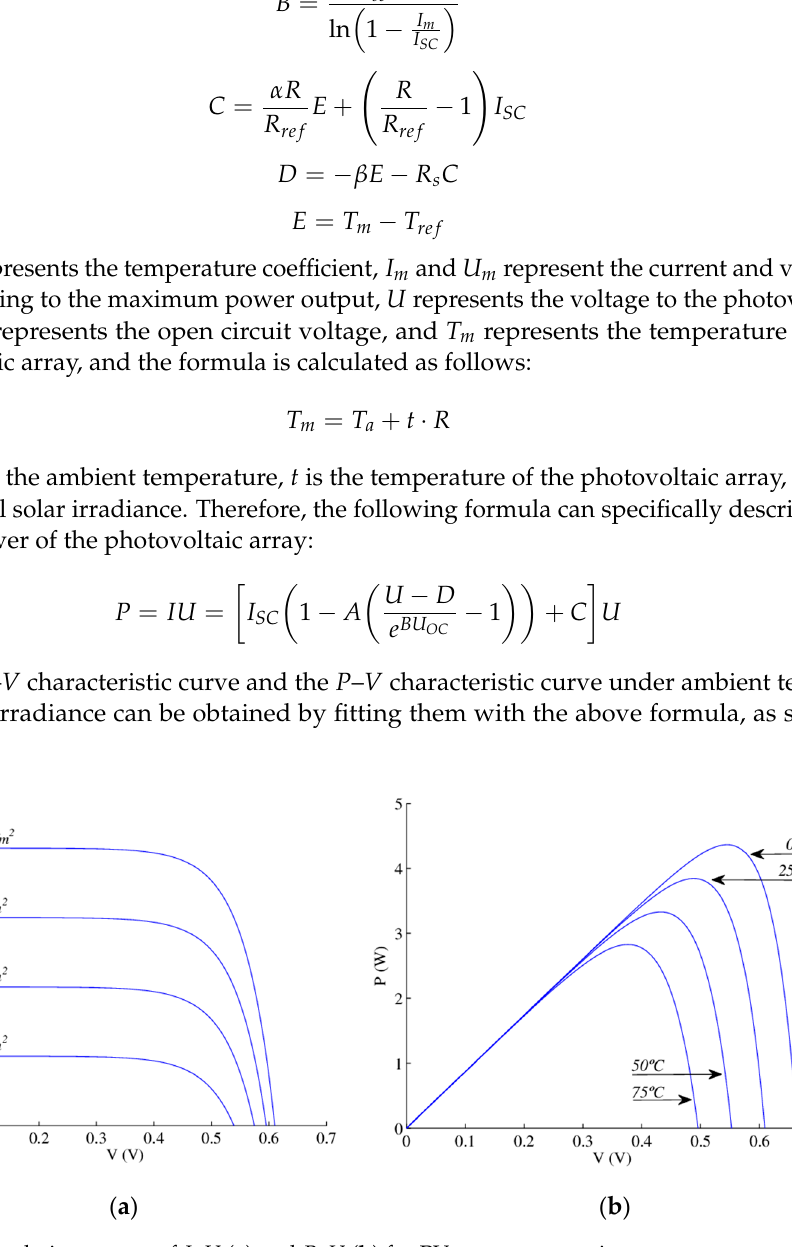
Figure 8. Photovoltaic power generation system simulation diagram.